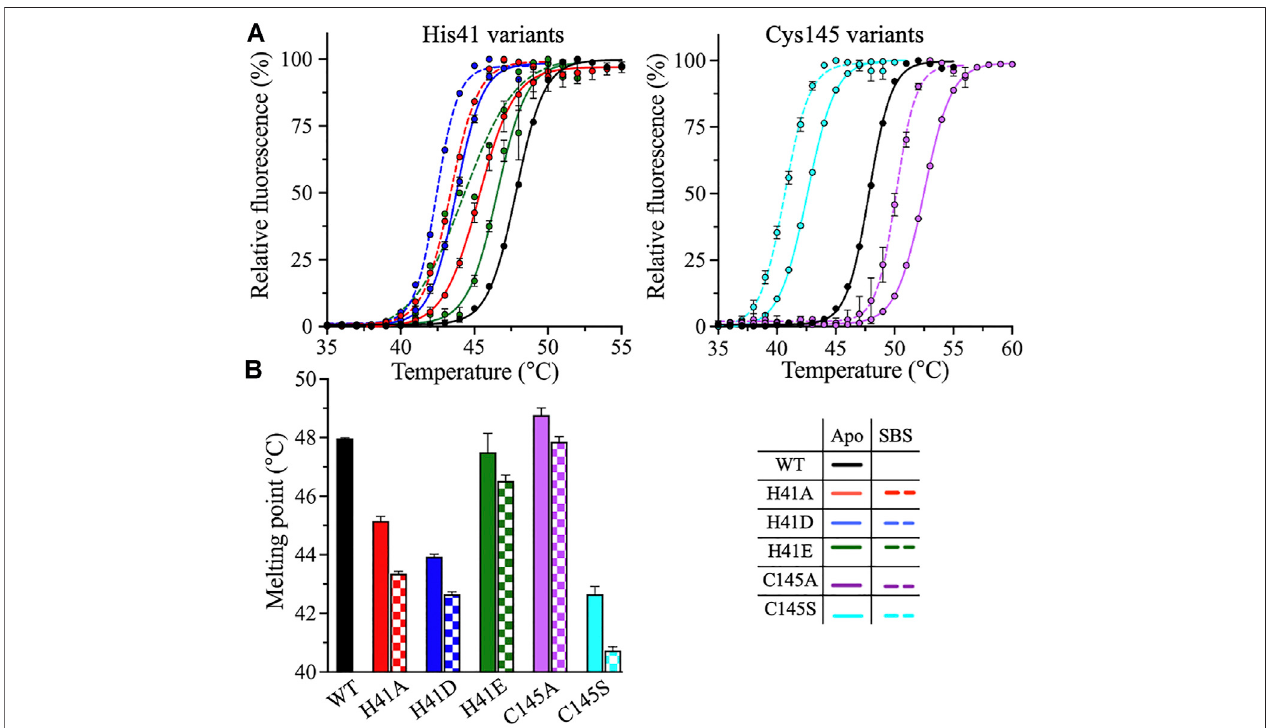
FIGURE 4 | DSF measurements of 3CLpro variants. (A) DSF thermal scans of 3CLpro WT, and His41 and Cys145 variants acquired at pH 7.0 and 20% (v/v) DMSO, withSYPRO Orangeasthereporterdye.Thescansofthevariants wereacquired intheabsence(solidline)orpresence(dottedline)of50 μ Mpeptide substrate. TheDSFscanofWTenzymewasnotacquiredinthepresenceofpeptidesubstrate,astheproteaseiscatalyticallyactive. (B) Barplotof T m calculatedfromthemidpoint of DSF thermal scansof 3CLpro in theabsence (solid bars) or presence (checkered bars) of 50 μ M peptide substrate. Colors are asin the bottom right panel. Data presented in (B) are shown as the mean + SD from, n (cid:2)